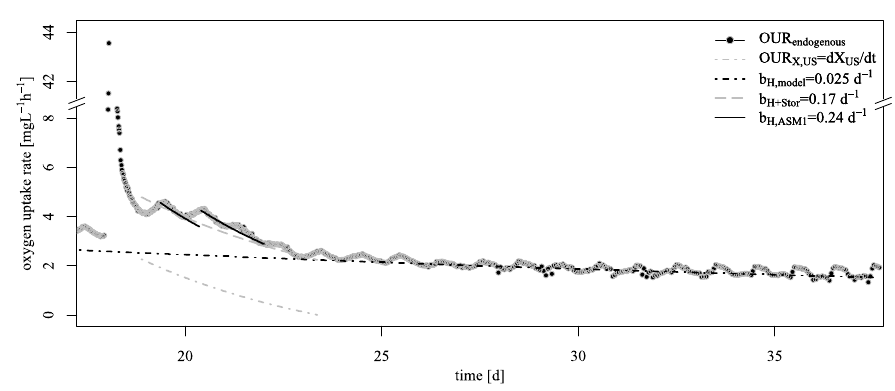
Figure 8. Results of endogenous OUR after substrate feeding.